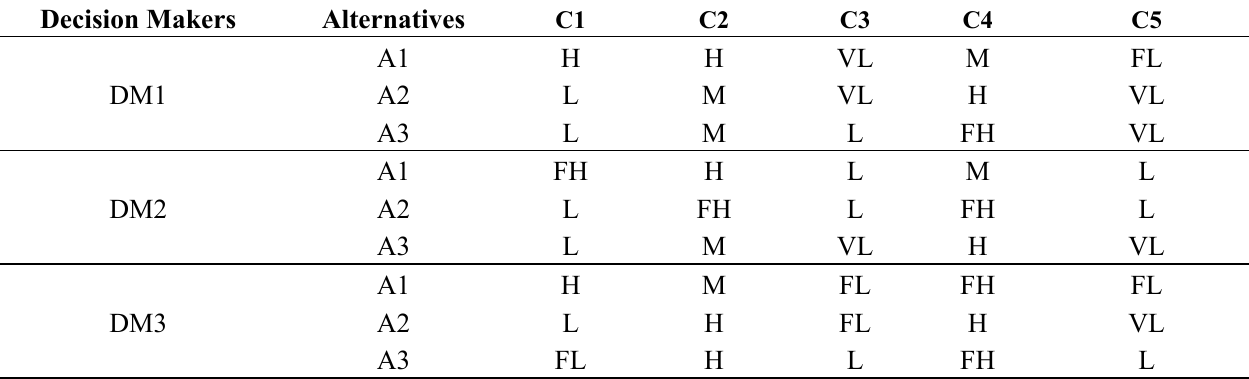
Table 3. Importance of storage alternatives with respect to criteria assessed by decision